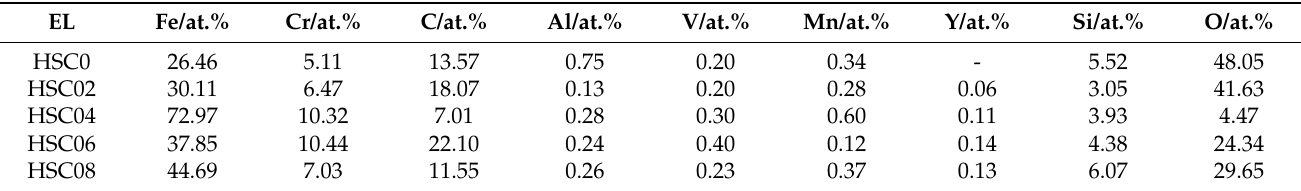
Figure 10. Wear surface image of the coating sample: ( a ) HSC0, ( b ) HSC02, ( c ) HSC04, ( d ) HSC06, ( e ) HSC08 (the inset image shows the corresponding EDS analysis). Table 6. Normalization elemental composition of the reciprocating wear surface. EL Fe/at.% Cr/at.% C/at.% Al/at.% V/at.% Mn/at.% Y/at.% Si/at.%